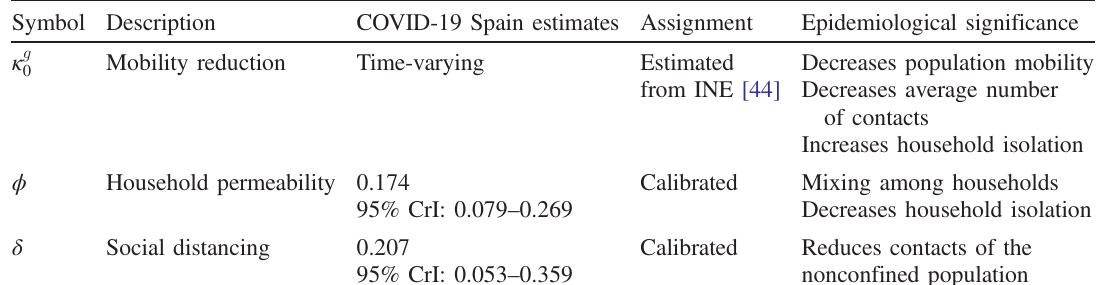
TABLE IV. Parameters describing the confinement and their estimations with 95% credible intervals for COVID- 19 in Spain, with strata separation g ∈ f Y; M; O g when appropriate. See Appendix A for a detailed